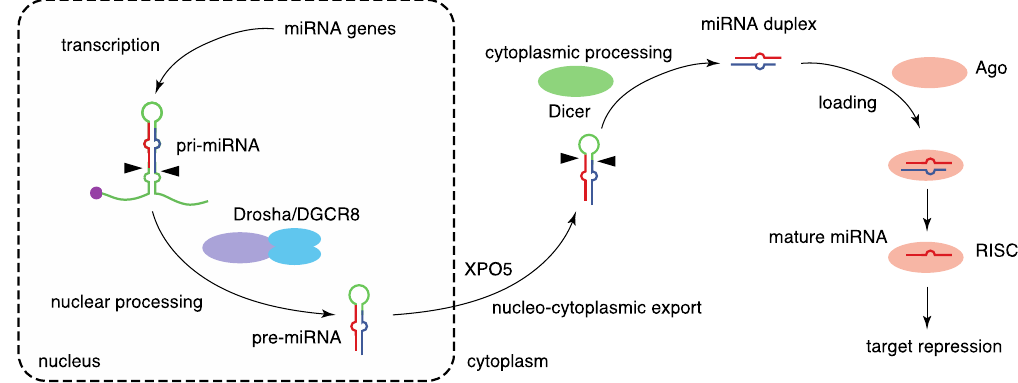
Figure 1. Biogenesis pathway of canonical miRNAs. miRNA biogenesis is mediated by multiple steps, including the transcription of primary miRNA transcripts, nuclear processing by Drosha, nucleocytoplasmic export by XPO5, cytoplasmic processing by Dicer, and formation of the RISC with Ago proteins.